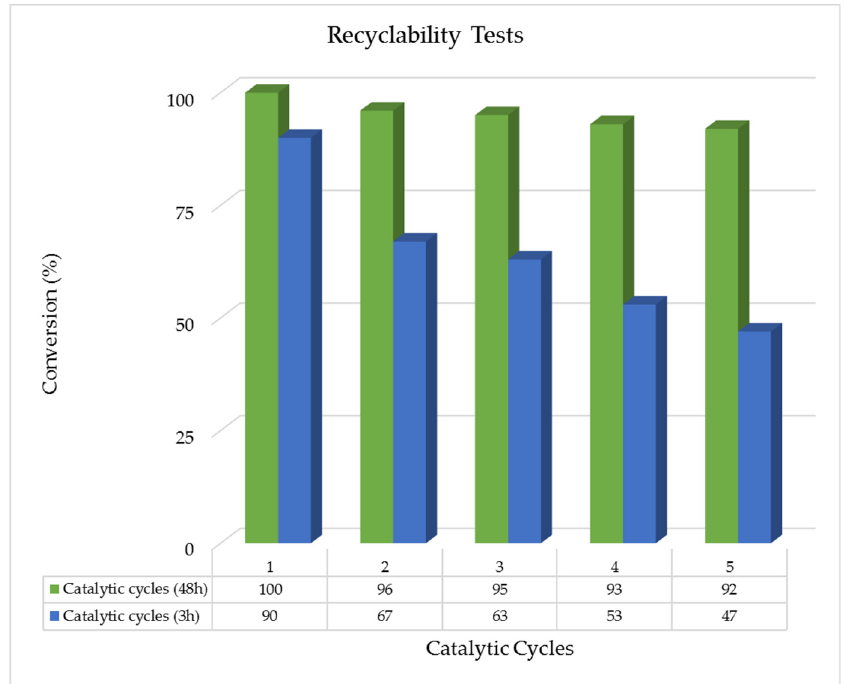
Figure 5. Recyclability tests of the consecutive reactions of 1 ‐ bromo ‐ 4 ‐ fluorobenzene and 4 ‐ fluorophenylboronic acid at 110 °C for 48 h (green) or 3 h (blue) catalyzed by G ‐ COOH ‐ Pd ‐ 10.